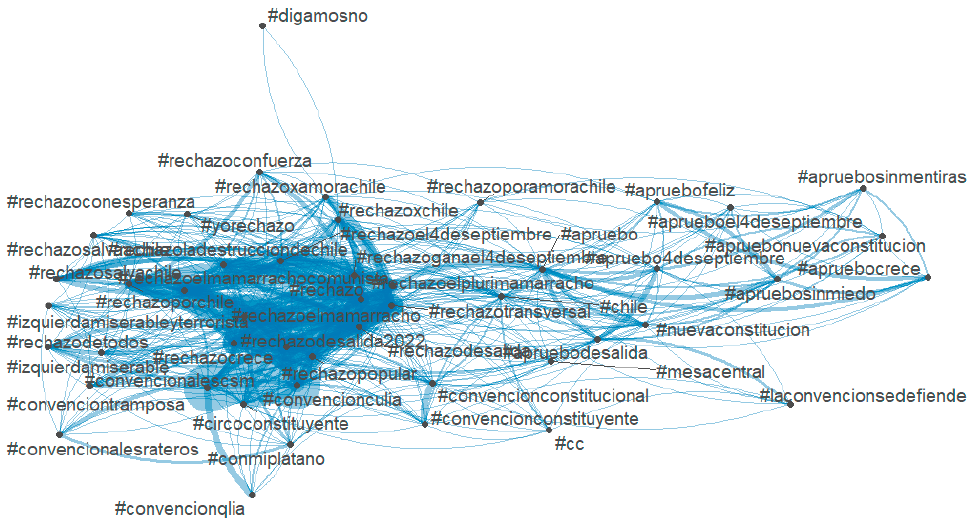
Figure 4. Network of hashtags with hate speech for Independientes 2022.